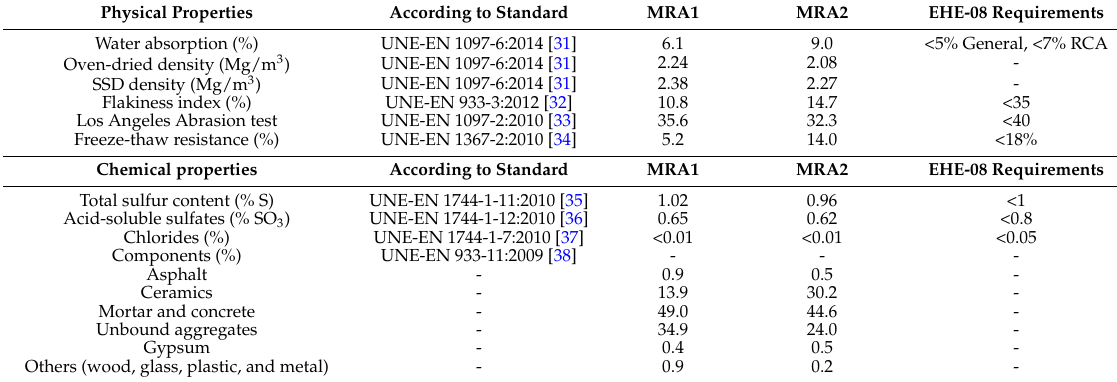
Table 1. Physical, chemical properties and components of mixed recycled aggregates (MRA). SSD: Saturated surface dry.